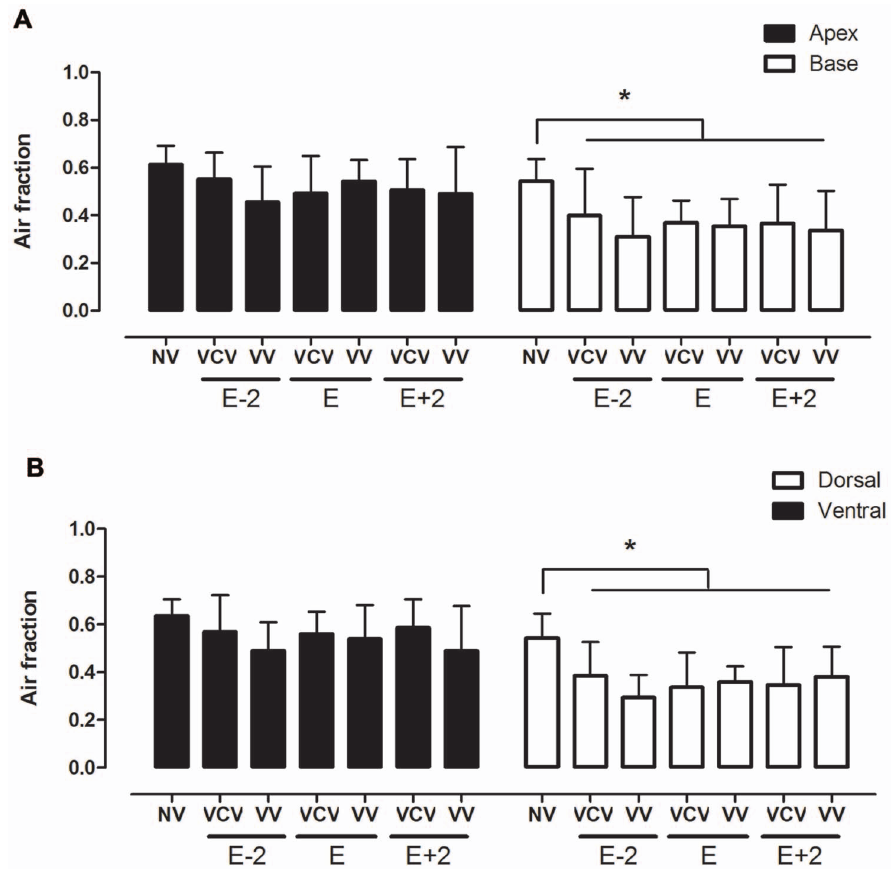
Figure 4. Plasmatic cytokines. Plasmatic concentration of TNF- a (A), IL-6 (B), CINC-1(C) and IL-1 b (D) ) in the groups: VCV_E (volume-controlled mode and PEEP minErs ; n=6), VCV_E + 2 (volume-controlled mode and PEEP minErs plus 2 cmH 2 O; n=6), VCV_E-2 (volume-controlled mode and PEEP minErs minus 2 cmH 2 O; n=6), VV_E (variable ventilation and PEEP minErs ; n=6), VV_E + 2 (variable ventilation and PEEP minErs plus 2 cmH 2 O; n=5), VV_E-2 (variable ventilation and PEEP minErs minus 2 cmH 2 O; n=6). Red lines represent mean values. Ventilatory mode and PEEP effects were tested with two-way ANOVA followed by Tukey post hoc. T-test was used to detect differences between ventilated and non-ventilated groups and then correction by multiple comparison. Statistical significance was accepted at p , 0.05. *p , 0.05.